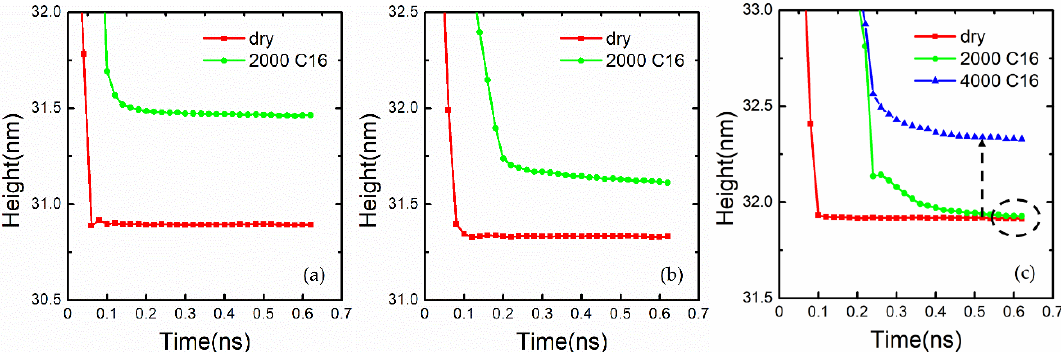
Figure 3 . Variation of the system heights with the time for the root mean square (RMS) = ( a ) 0.2 nm, ( b ) 0.5 nm, ( c ) 0.8 nm under 0.25 MPa. The red lines indicate dry contact while the green and blue lines indicate lubricated contact with 2000 and 4000 hexadecane molecules, respectively.